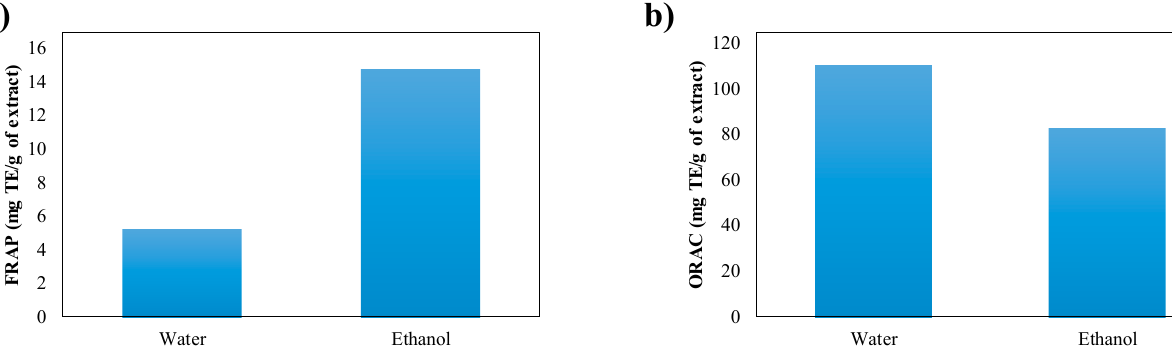
Figure 5. Effect of the solvent on antioxidant capacity: ( a ) effect of the solvent on FRAP and ( b ) effect of the solvent on ORAC. Results are expressed on a dry basis. Standard deviation by ANOVA for FRAP = 1 and for ORAC = 9.